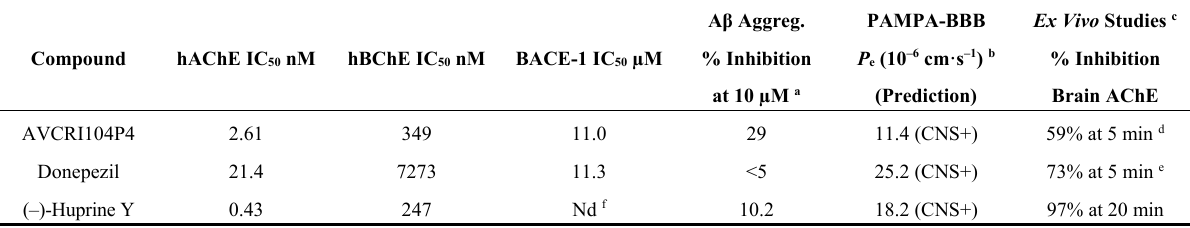
Table 1. In vitro and ex vivo biological profile of AVCRI104P4 relative to the parent compounds donepezil and huprine Y